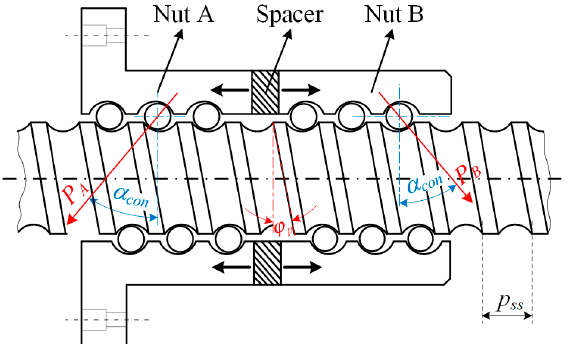
Figure 3. Cross-sectional view of a typical gasket-type double-nut ball screw joint.